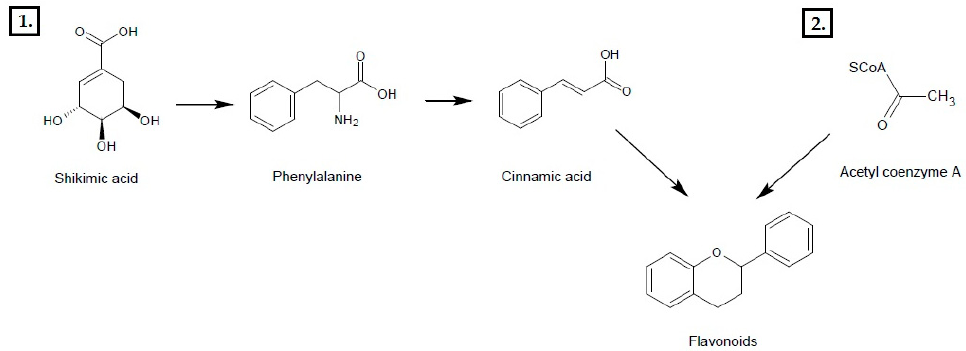
Figure 1. Biosynthesis of Flavonoids. 1. The shikimic acid pathway; 2. The acetate pathway.